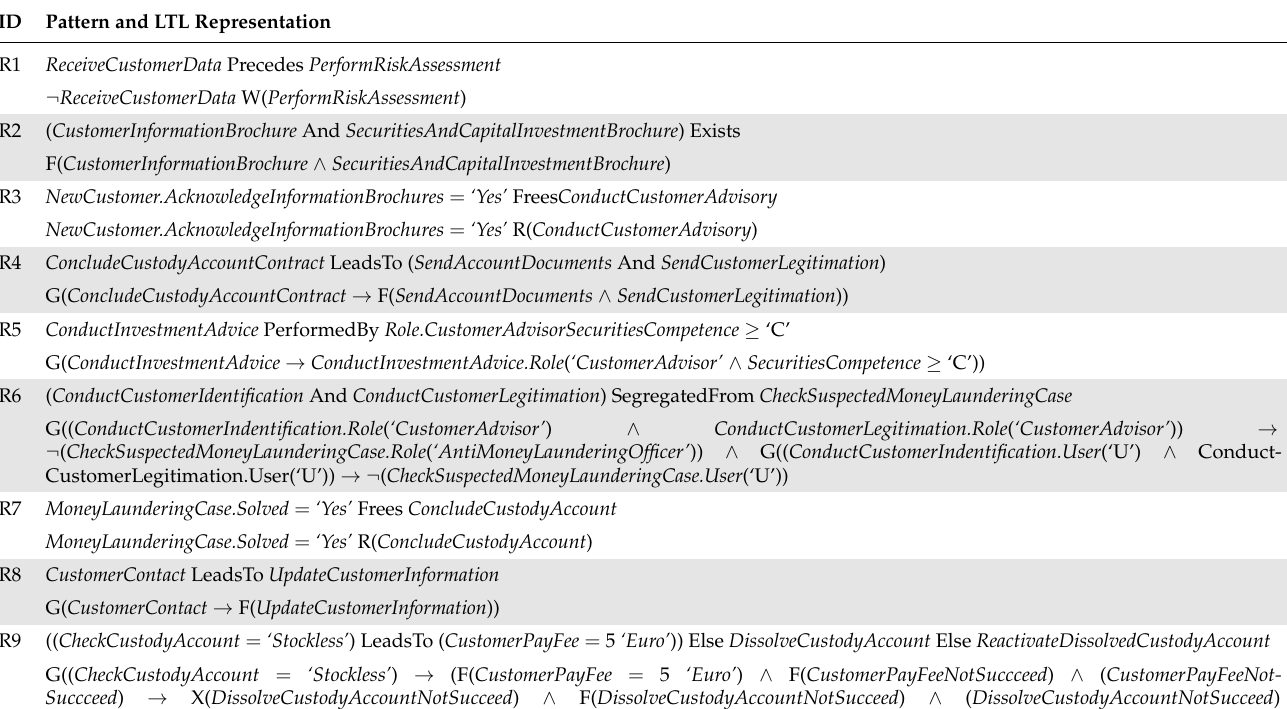
Table 7. Mapping of formalised requirements using CRL patterns to LTL